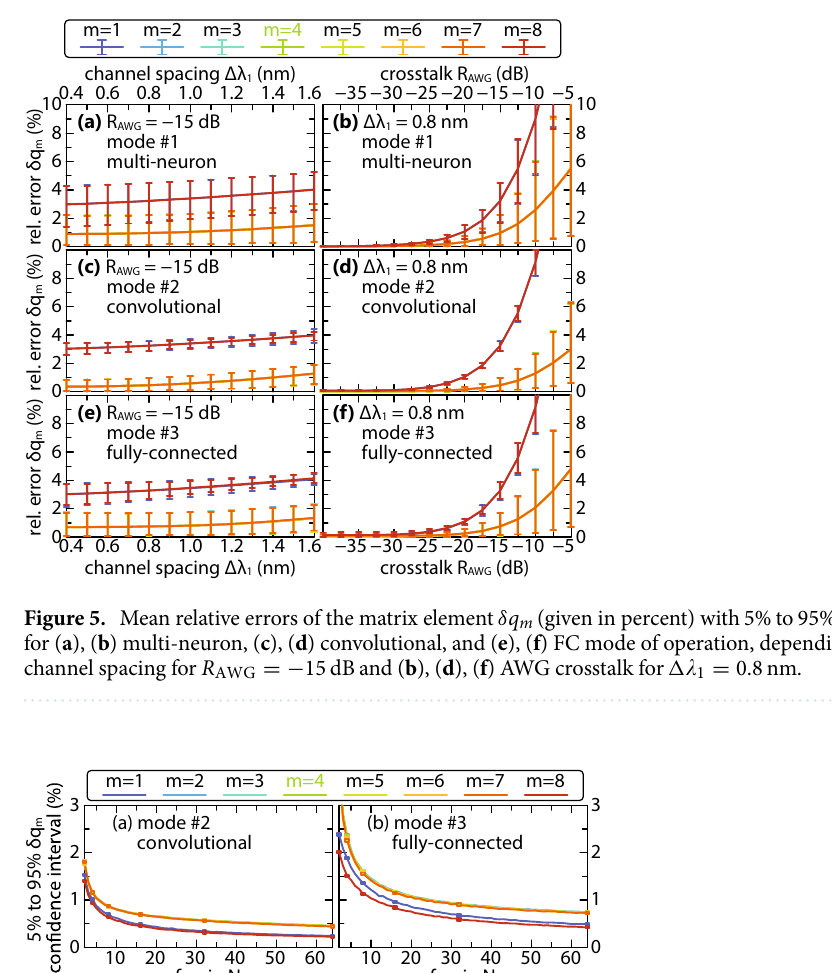
Figure 6. Relative error 5–95% confidence interval (given in %) versus the neuron fan-in N at (cid:31) (cid:31) 1 15dB for ( a ) convolutional and ( b ) fully-connected and R AWG = −